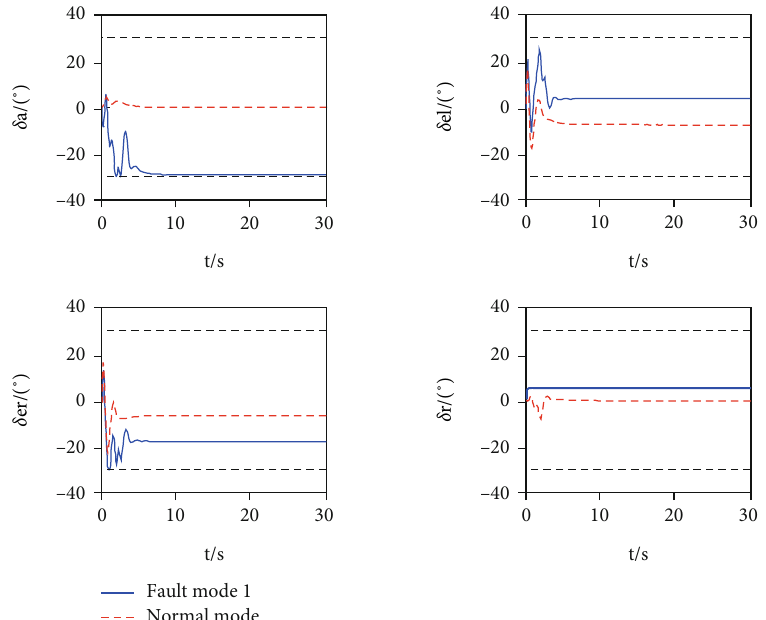
Figure 5: The de fl ection angle of surfaces against fault mode 1. The remaining surfaces compensate for the abnormal forces and torques caused by the stuck actuator attached to